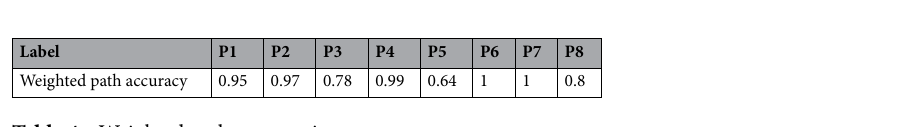
Table 4. Weighted paths